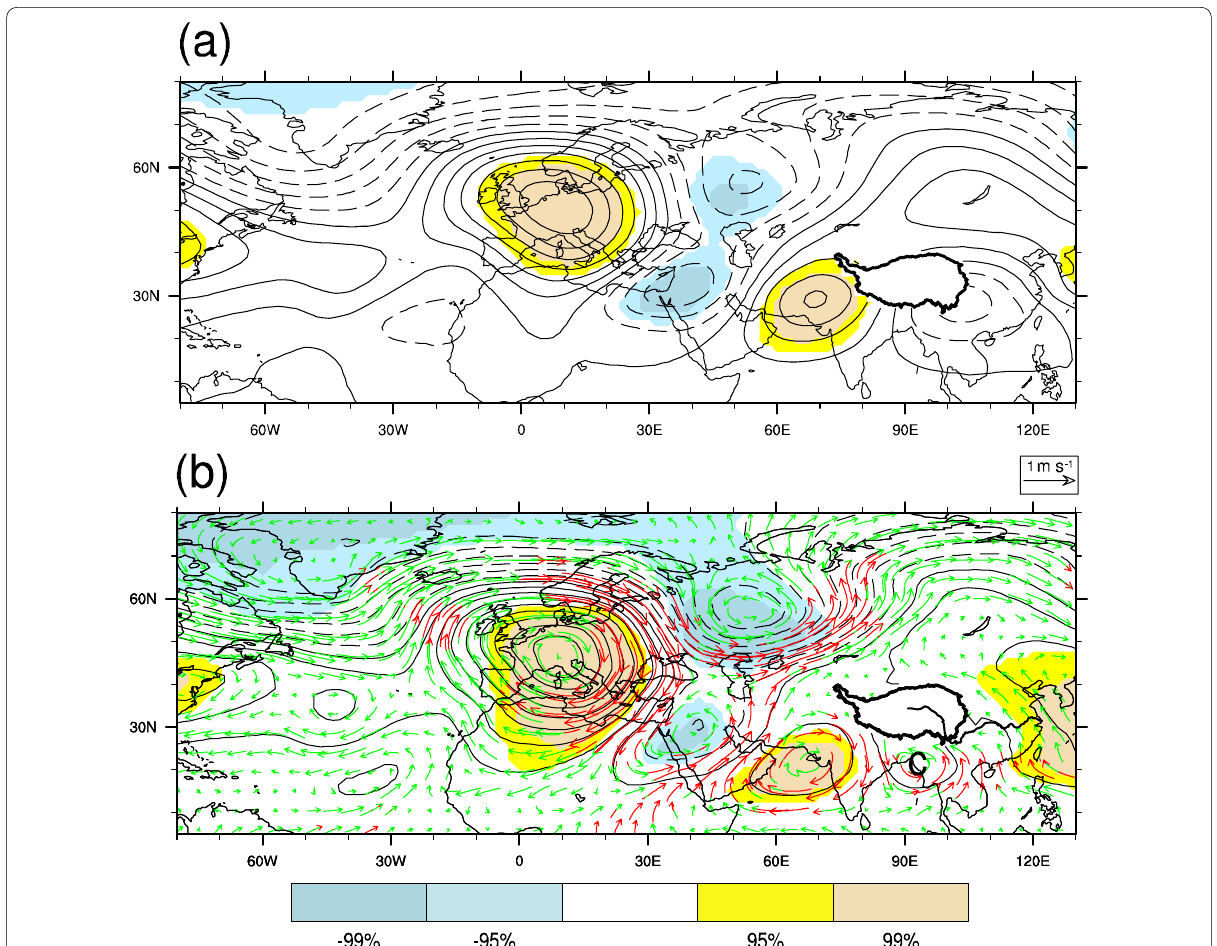
Fig. 8 Anomalous ( a ) 200‑hPa and b 700‑hPa geopotential heights (contours interval: 40, m 2 s − 2 ) regressed upon the NIBT index for the period 1979–2019, in which shadings denote positive/negative geopotential height anomalies significant at the 95% and 99% confidence levels as shown by the color bars. Anomalous 700‑hPa winds (units: m s − 1 ) are also presented in (b). The anomalous winds significant at the 99% confidence level are highlighted in red. “C” over the BoB denotes the anomalous anticyclone affecting the NIBT. The thick black contour denotes the Tibetan